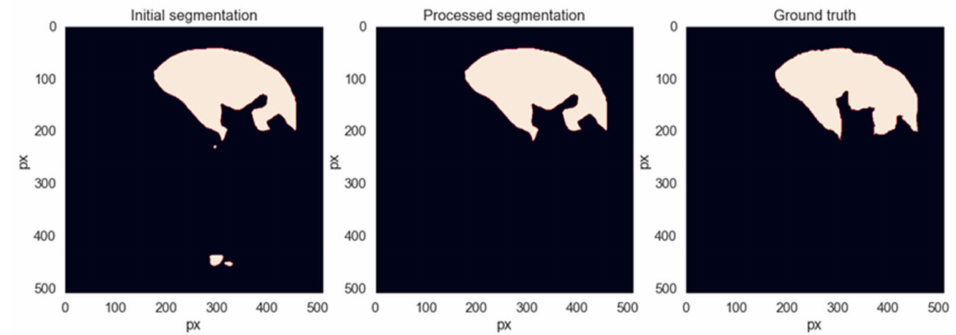
Figure 8. Example of segmentation